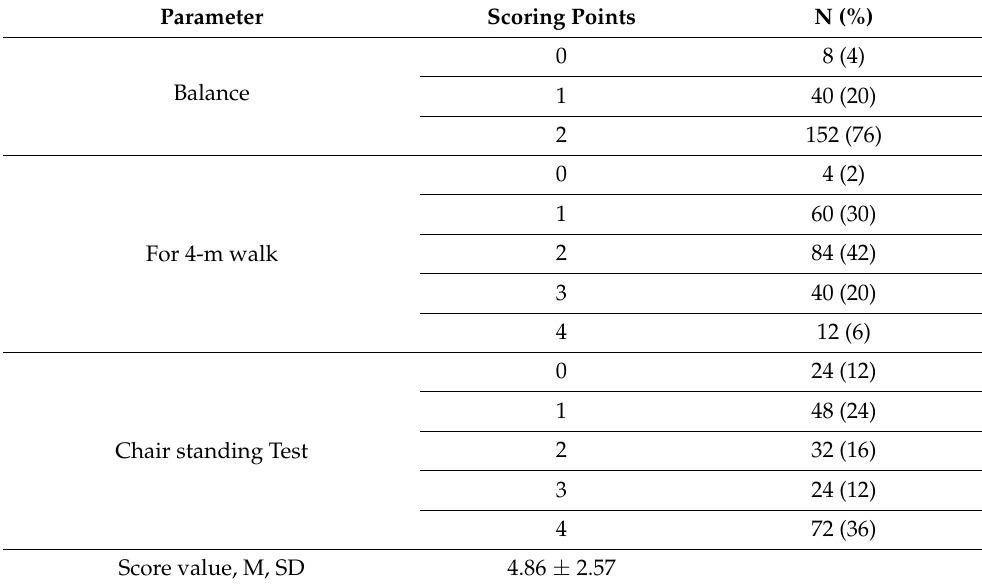
Table 2. Results of the SPPB test applied for sarcopenia